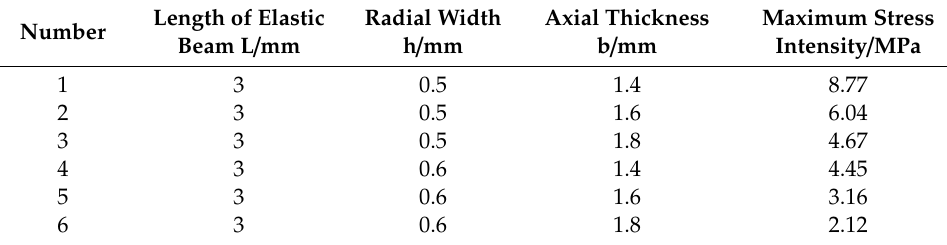
Table 1. The finite element analysis results of different traditional elastic beam size.